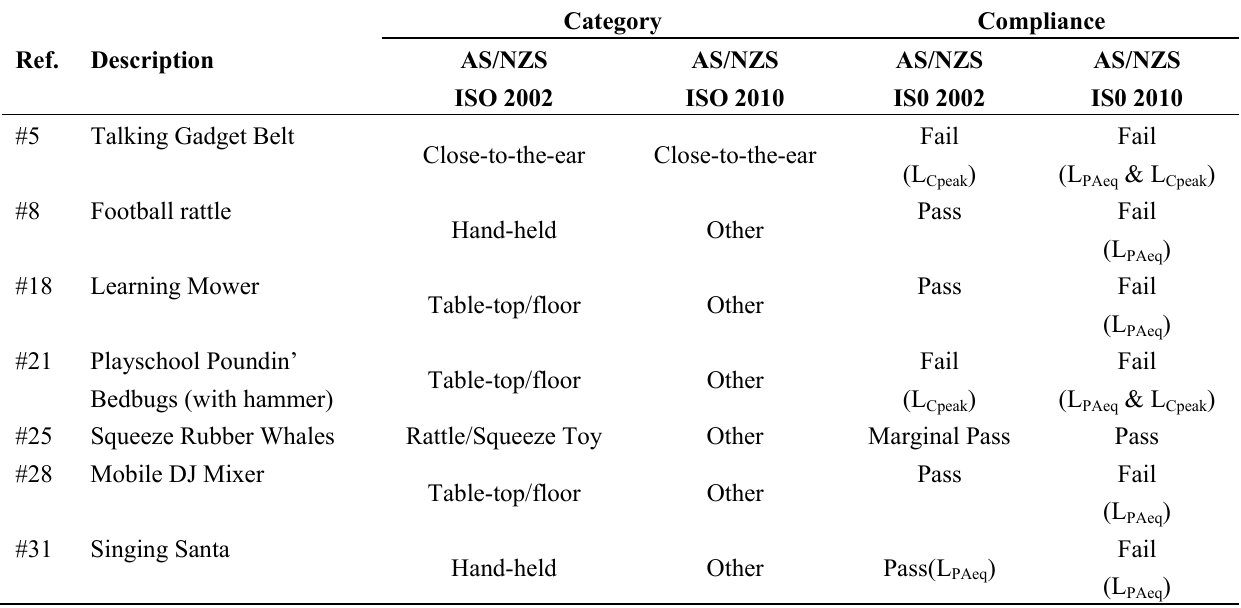
Table 5. Comparison of compliance between the AS/NZS ISO 8124.1:2002 and 2010 standards for toys that failed or marginally